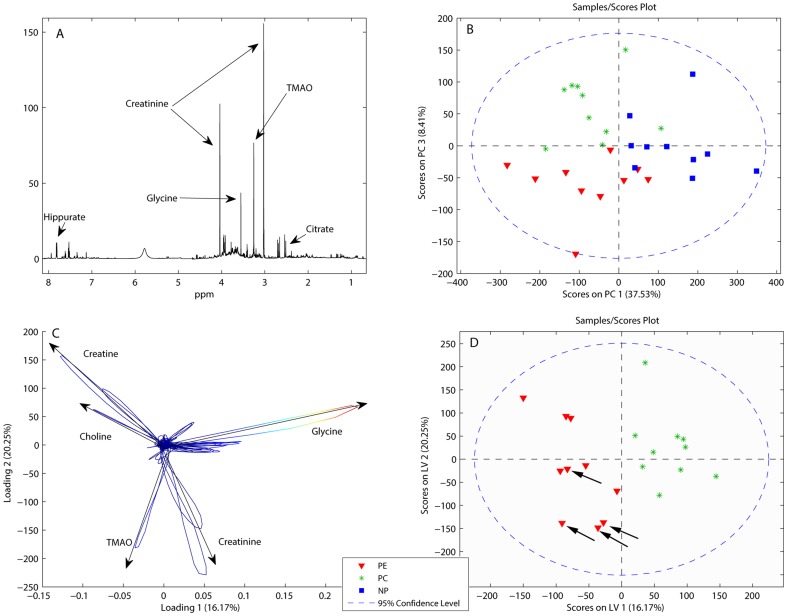
Results from urine analysis.Results from Principal Component Analysis (PCA) and Partial Least Squares Discriminant Analysis (PLS-DA) of urine samples from women with preeclampsia (PE, pregnant controls (PC) and non-pregnant controls (NP). A) Typical high resolution NMR spectrum of urine from a PE subject, most abundant metabolites annotated. B) PCA score plot separating all three groups in two dimensions. C) Loading Variables (LV) 1 and 2 of the PLS-DA used to create a model discriminating between PE and PC groups. Arrow direction indicates increased metabolite level. D) Scores on LV1 and LV2 showing a clustering of early onset PE samples (marked by arrows). TMAO: Trimethylamine-N-Oxide.